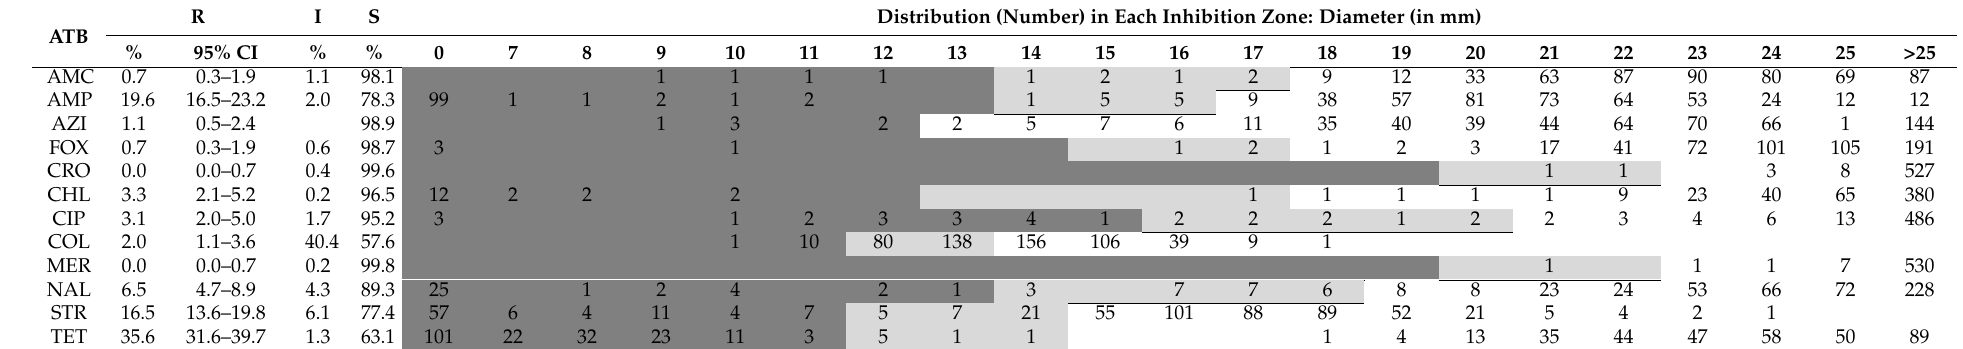
Table 1. Susceptibility to antibiotics of E. coli ( n = 540) from food animals in the East province of